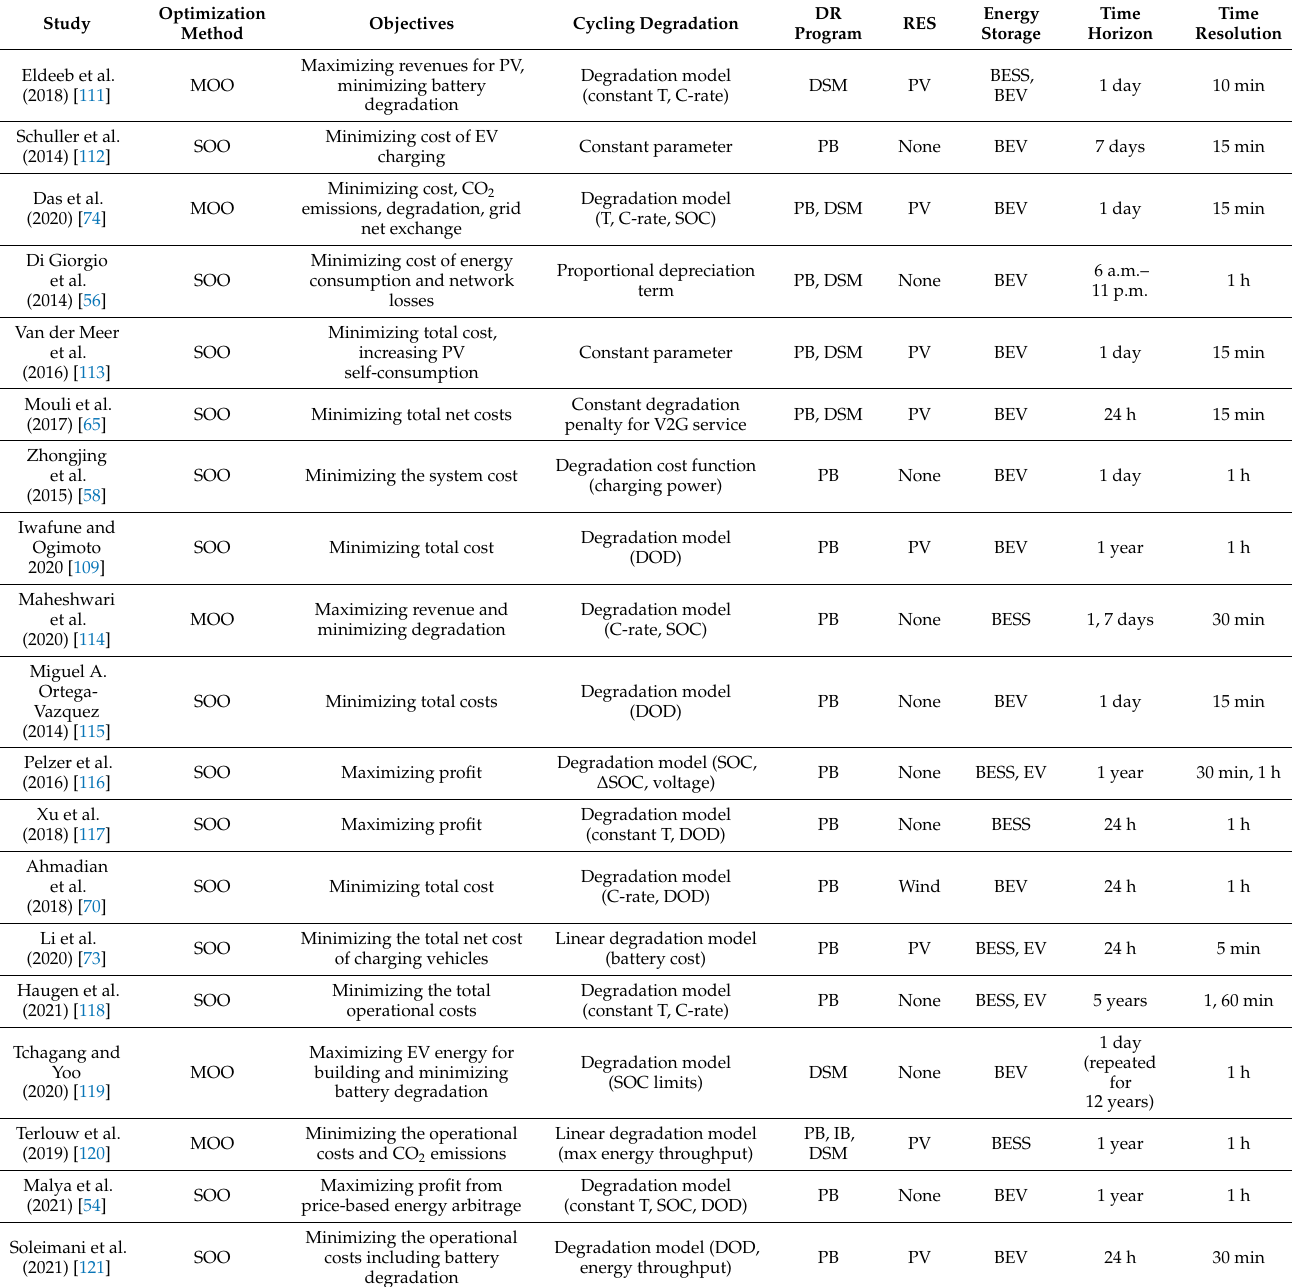
Table 3. Optimization scenarios in smart grids considering battery